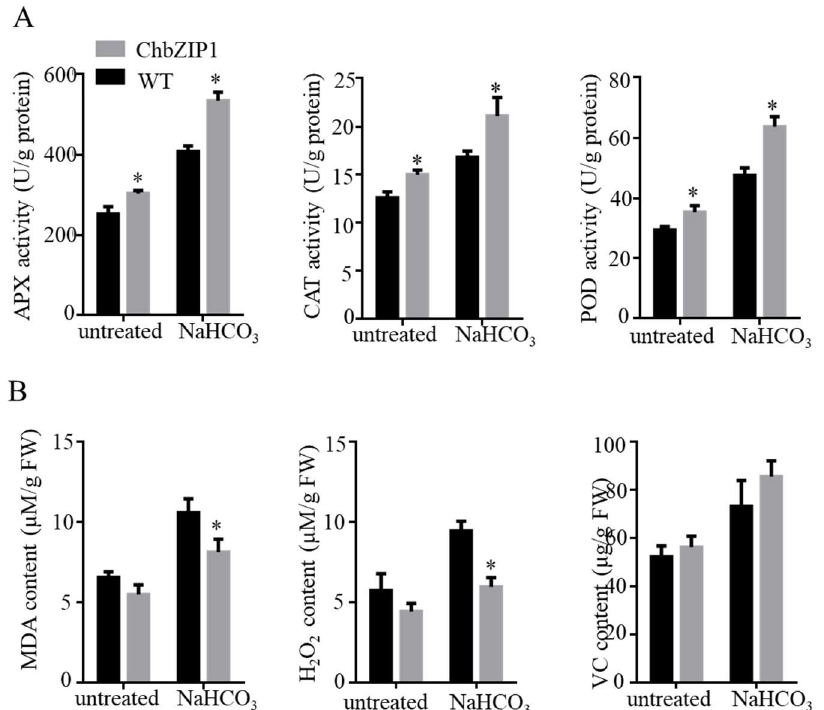
Figure 7. Effects of NaHCO 3 stress on the antioxidant ability in wild-type (WT) and ChbZIP1 overexpressed transgenic Arabidopsis plants. ( A ) Measure of the enzymatic activities of APX, CAT, and POD in ChbZIP1 transgenic and WT seedlings compared to NaHCO 3 stress and control. ( B ) Measure of the content of MDA, H 2 O 2 , and Vc in ChbZIP1 transgenic and WT seedlings compared to NaHCO 3 stress and control. * indicates p -value < 0.05.